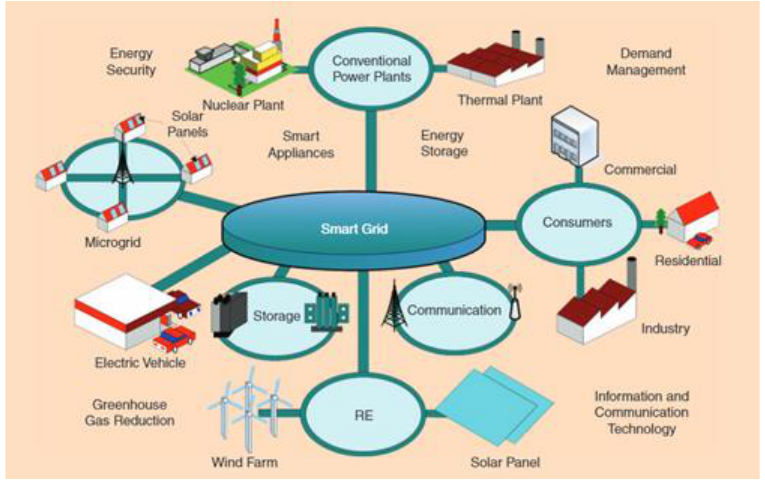
Figure 1. A traditional grid network system Adapted with permission from Ref. [9]. 2011, Xinghuo Yu.